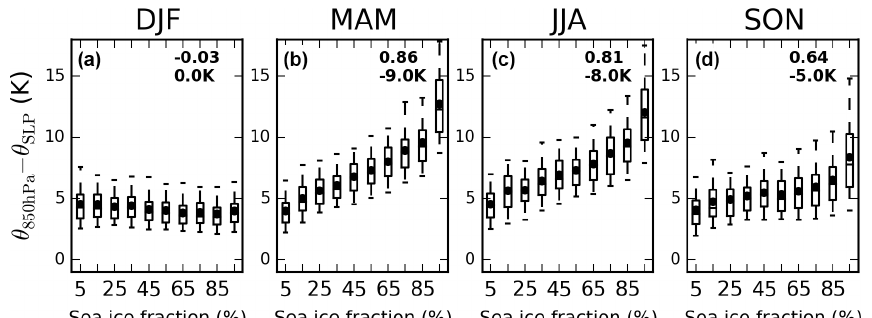
Figure 16. Whisker plots showing the potential temperature difference θ 850hPa - θ SLP as a function of the sea ice fraction for each season. The potential temperatures are derived from the ECMWF temperatures and pressure profiles are collocated with the satellite overpasses at the DARDAR footprint level. The Spearman’s rank correlation coefficient between θ 850hPa - θ SLP and the sea ice fraction is derived over the whole sample that is used to then compute the whisker plots, and it is indicated at the top-right corner of each panel. The p values for the correlation coefficients are always < 0 . 01, except for summer ( p value = 0 . 03). The absolute difference (in K) in near-surface static stability between open water (sea ice fraction < 5%) and sea ice (sea ice fraction > 95%) is indicated below each correlation